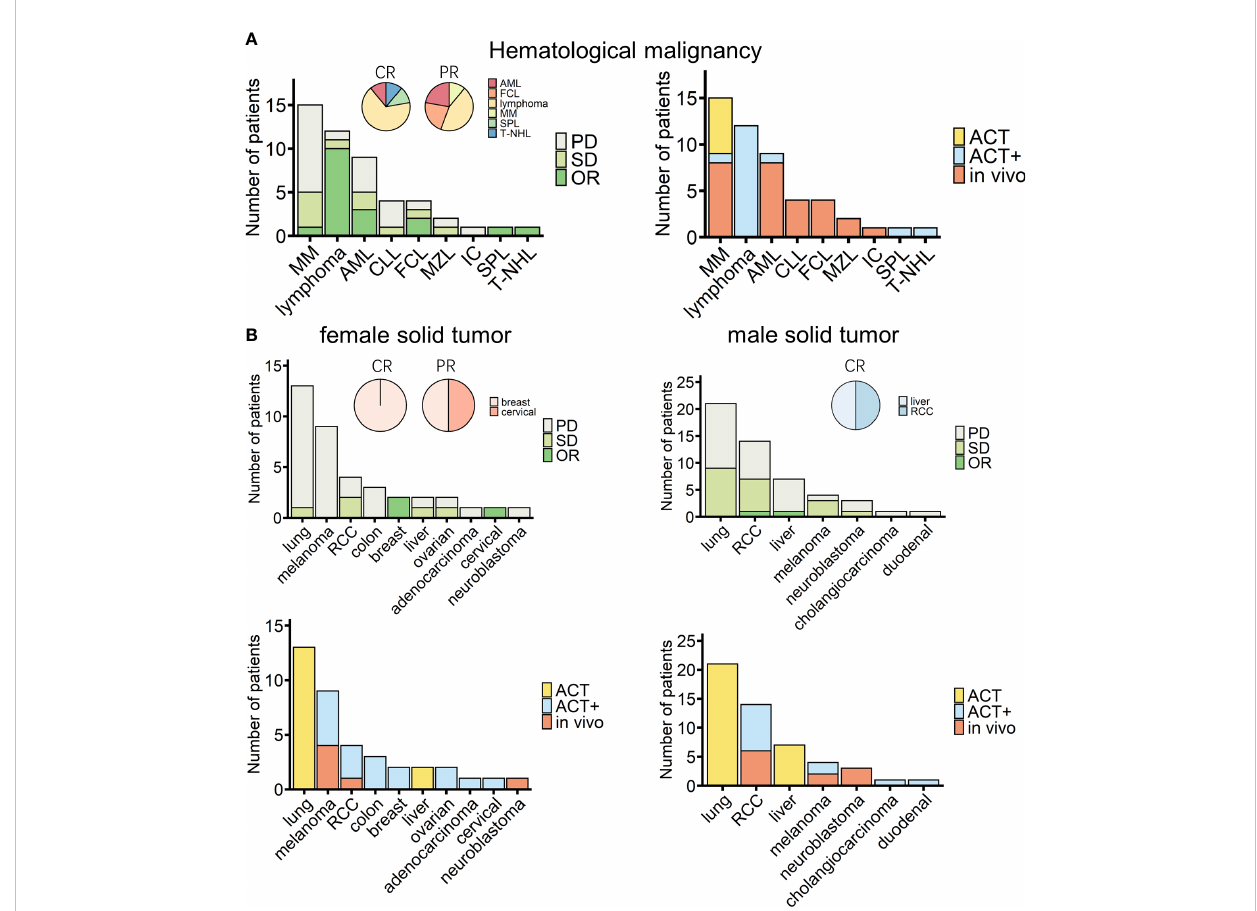
FIGURE 4 Overview of cancer types of patients treated with gd T-cell immunotherapy ( n = 138). (A) Diseases (left) and chosen treatment strategies (right) of hematological cancer patients ( n = 49). Pie charts show the proportions of patients who achieved a complete response (CR) or a partial response (PR) after treatment (CR, n = 9; PR, n = 9). (B) Diseases (upper) and chosen treatment strategies (lower) of female (left) and male (right) solid tumor patients (female, n = 38; male, n = 51). Pie charts show the proportions of patients who achieved a CR or PR after treatment (female CR, n = 1; female PR, n = 2; male CR, n = 2). MM, multiple myeloma; AML, acute myeloid leukemia; CLL, chronic lymphocytic leukemia; FCL, follicle center lymphoma; MZL, mantle zone lymphoma; IC, immunocytoma; SPL, secondary plasma cell leukemia; T-NHL, T-cell non-Hodgkin lymphoma; RCC, renal cell